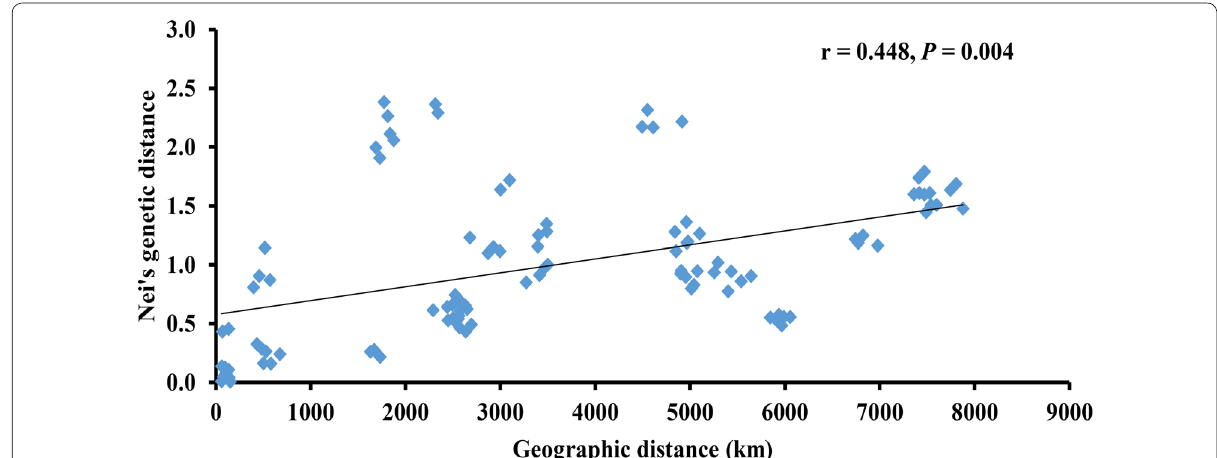
Fig. 4 Mantel test for isolation by distance between Nei’s genetic distance and geographic distance (km) for the N. nucifera